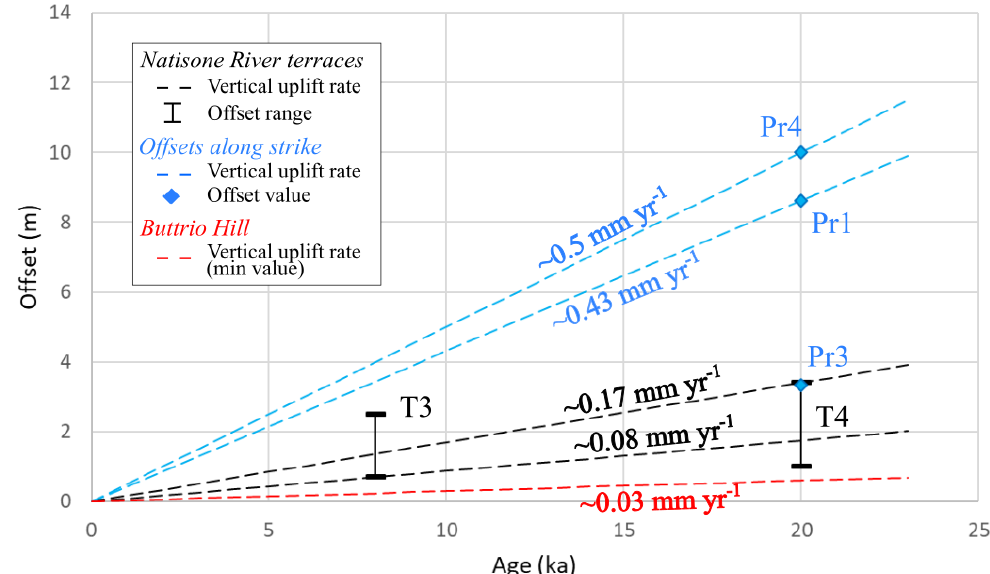
Figure 14. Diagram of computed vertical uplift rates related to the Udine-Buttrio Thrust. The black dashed lines define the vertical uplift rate range, which matches both offset intervals of T3 and T4 (reported in Table 1) displayed by black vertical segments. The blue dashed lines indicate the vertical uplift rate values measured by the swath profiles 1, 3 and 4 along the Udine-Buttrio strike (see Figure 3). The blue diamonds represent the corresponding offset measurements (reported in Table 1). The blue line corresponding to the offset of Pr3 was not reported since it overlaps the black one of terrace T4. The red dashed line defines the vertical uplift rate related to the 80 m geological offset measured by the swath profile crossing the Buttrio Hill (Figure 4). This value represents a minimum estimate based on a conservative age of the